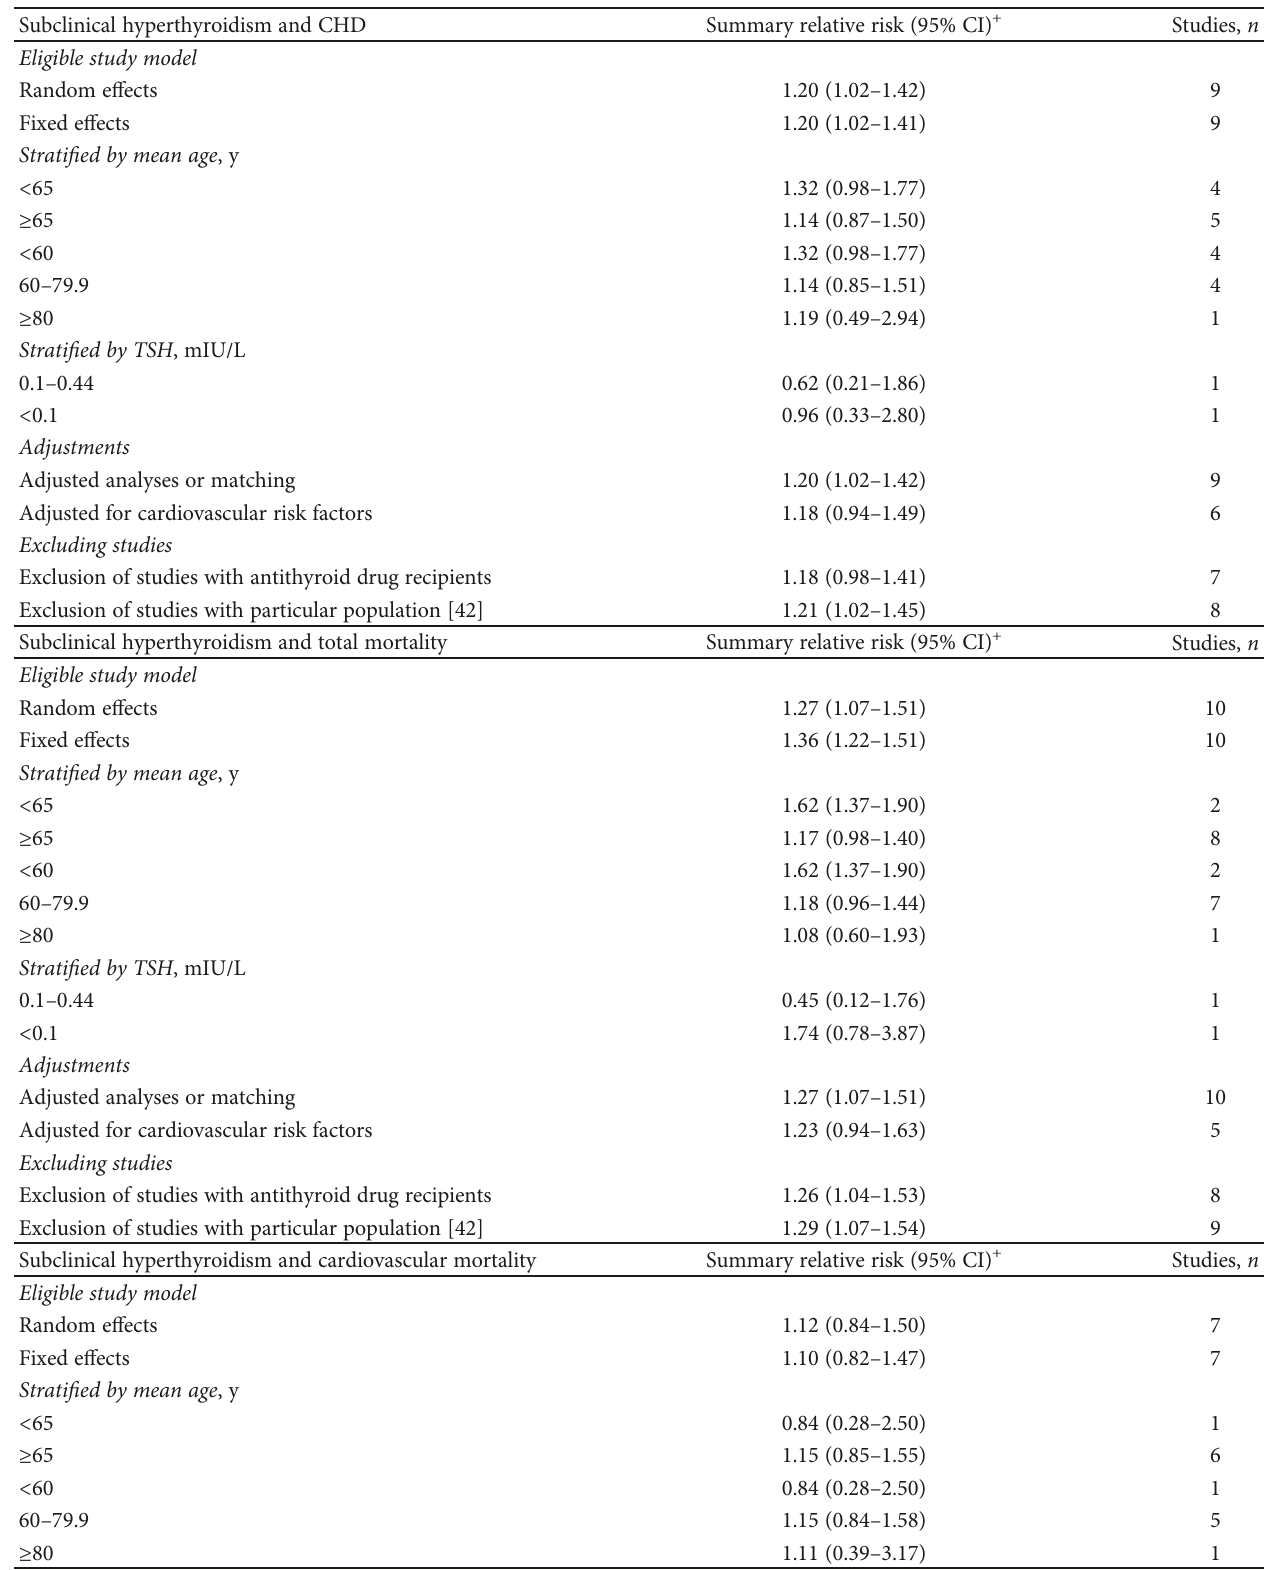
Table 3: Strati fi ed and sensitivity analysis of the subclinical